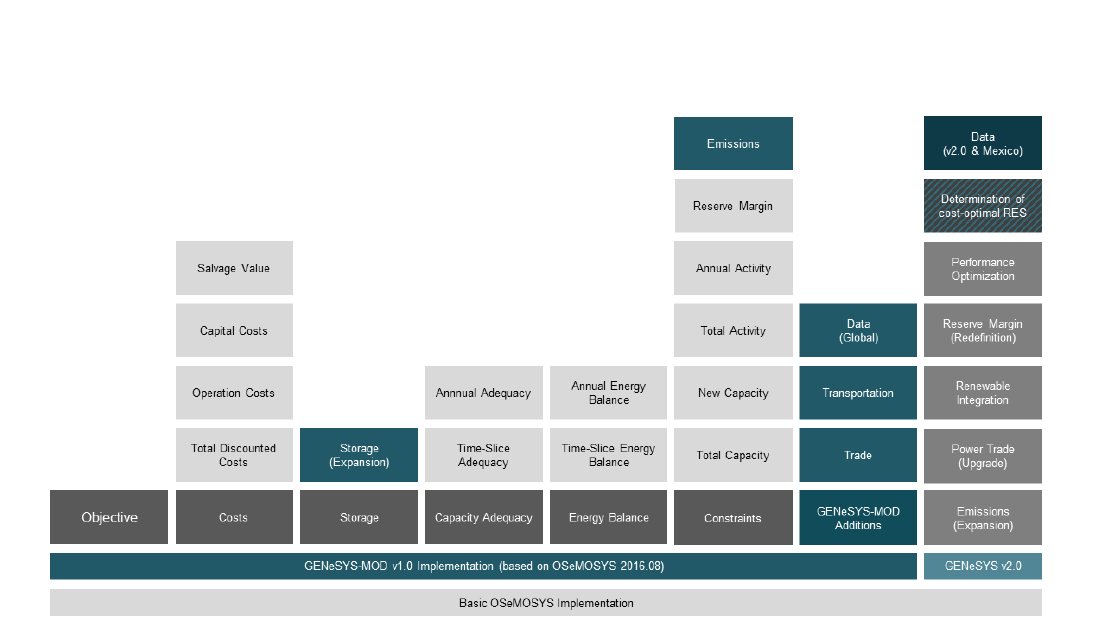
Figure A1. Model structure of the GENeSYS-MOD implementation used in this